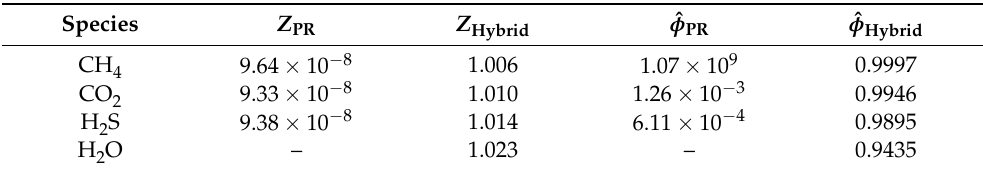
Table 3. Results comparison between the mixture fugacity evaluated with the PR and with the hybrid